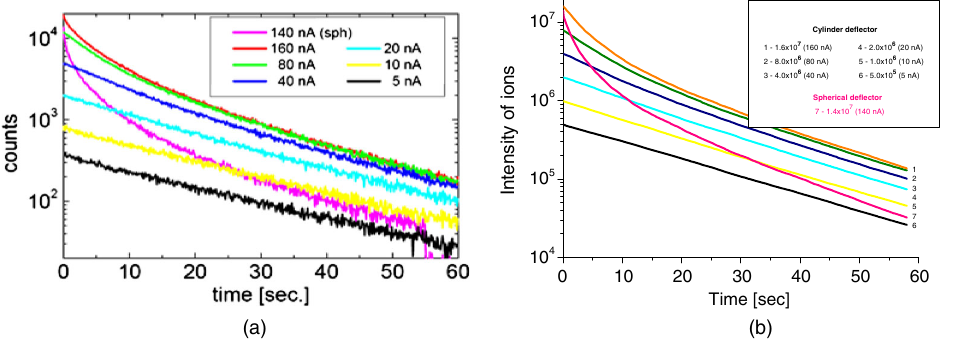
FIG. 2. Decay of stored O (cid:3) ions in ELISA at 22 keV beam energy: (a) experimental data, from [15]; (b) BETACOOL simulations [26,27]. The pink curve shows the drop of the beam current in the ELISA ring with electrodes of spherical shape; all remaining data refer to the ELISA ring equipped with cylindrical